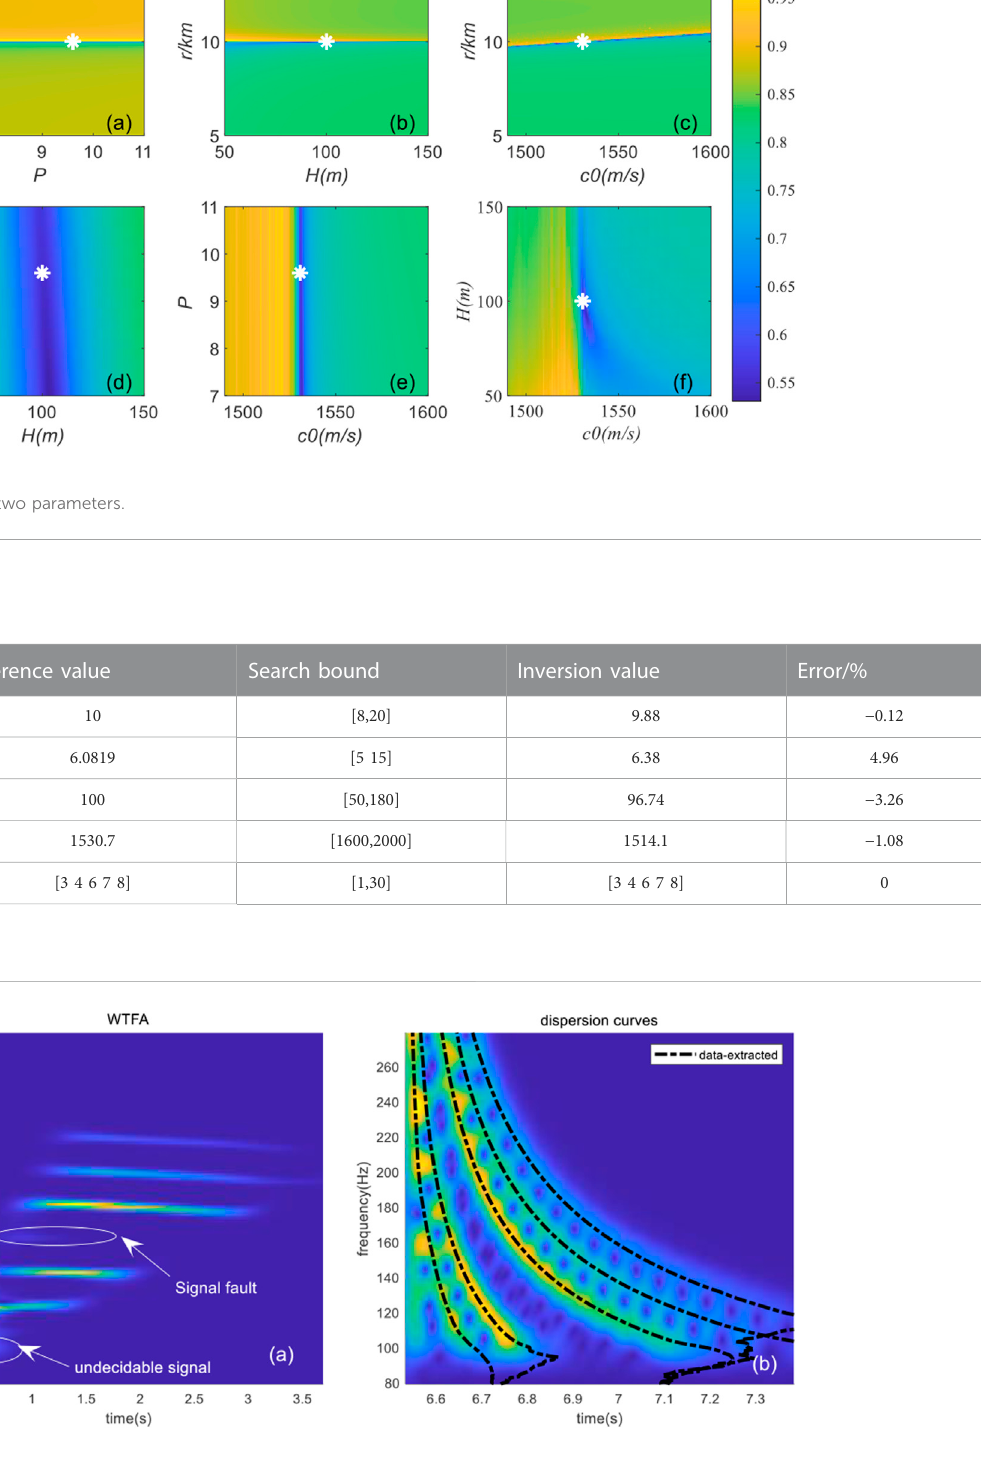
FIGURE 8 Received data: (A) spectrogram of the warped signal; (B) TFA results of the received data and the extracted dispersion